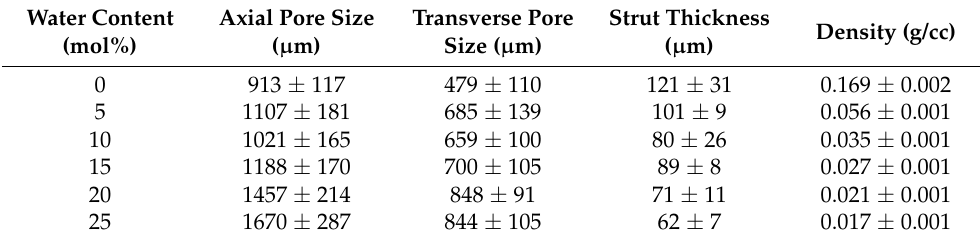
Table 2. Pore size and density of SMP foams with increasing water content.